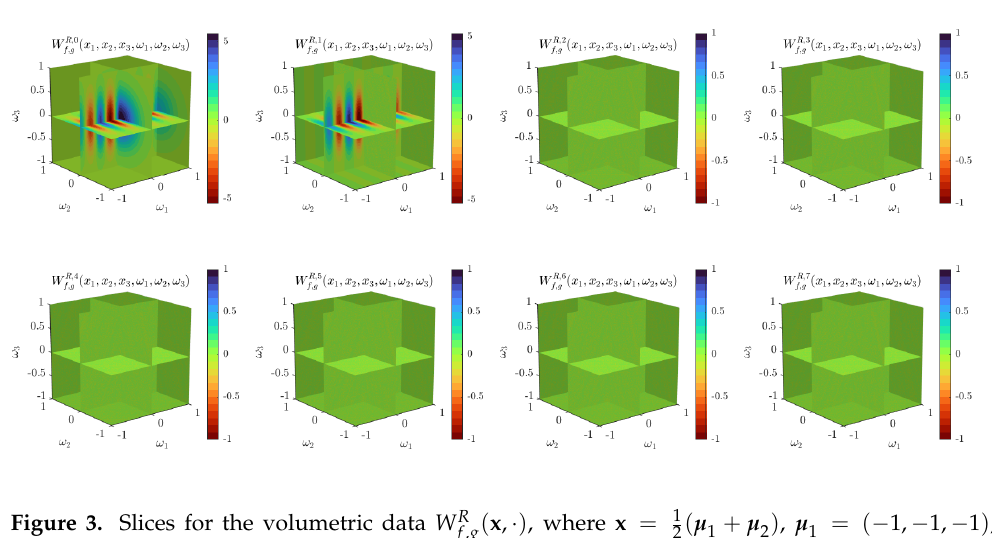
( µ + µ ) , µ = ( − 1, − 1, − 1 ) , 1 2 1 2